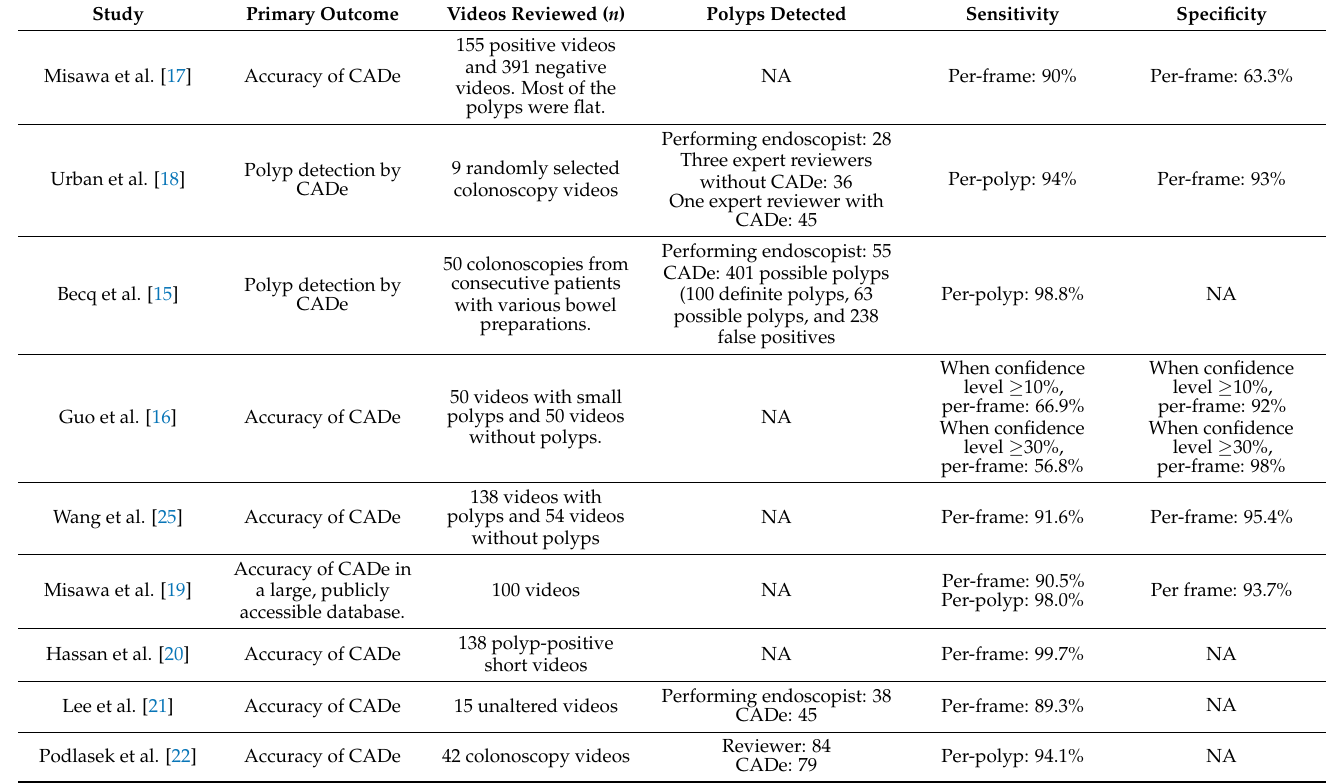
Table 2. Recent studies using CADe-overlaid videos for real-time detection of